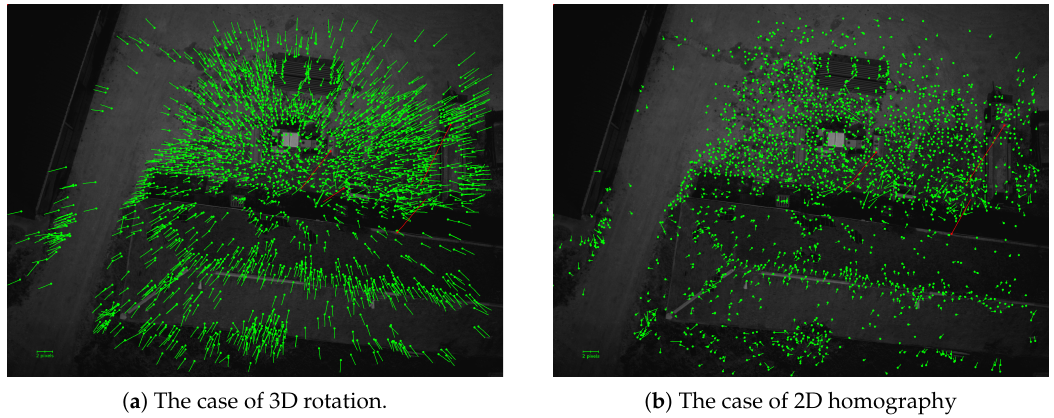
Figure 17. Residues obtained using the transformation estimation between the first image and the 10th image in the case of non-pure rotation mouvement of the camera. Red arrows represent the outliers.